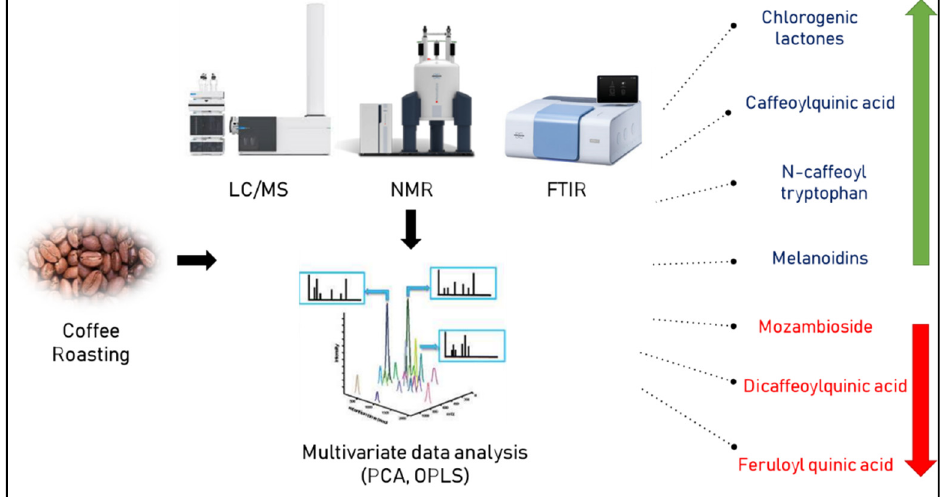
Figure 2. Metabolic markers indicative of roasting degree of coffee as determined by different metabolomic approaches. Green and red arrows indicate increase or decrease upon roasting, respec- tively.